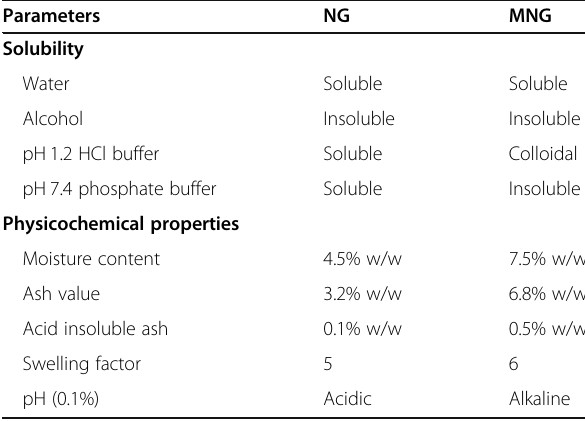
Table 3 Solubility behaviour and physicochemical properties of NG and